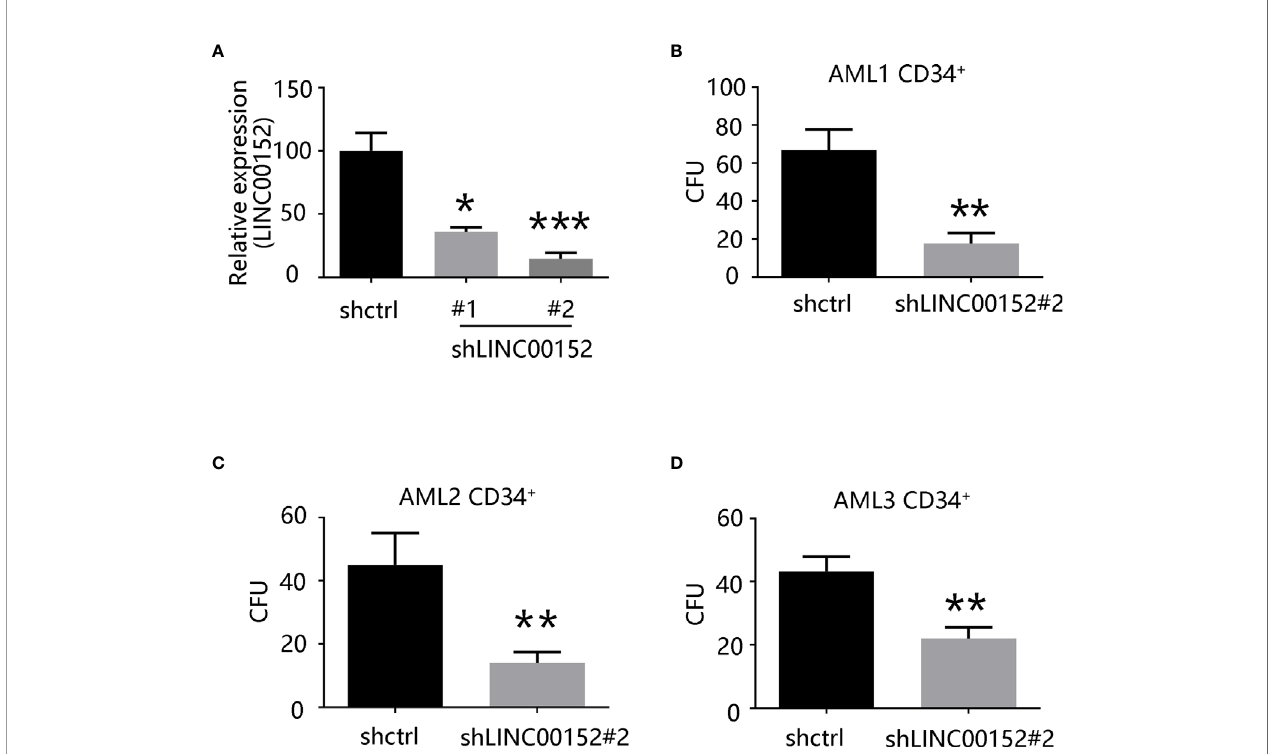
FIGURE 3 | LINC00152 knockdown decreases the capacity of colony formation of LSCs. (A) LINC00152 expression in cells transfected with short hairpin RNAs (shCTRL or sh00152s) (* P < 0.05, *** P < 0.001). (B – D) Quanti fi cation of colony formation derived from three acute myeloid leukemia patients. Data are presented as the mean ± SEM of three independent experiments (* P < 0.05, ** P <